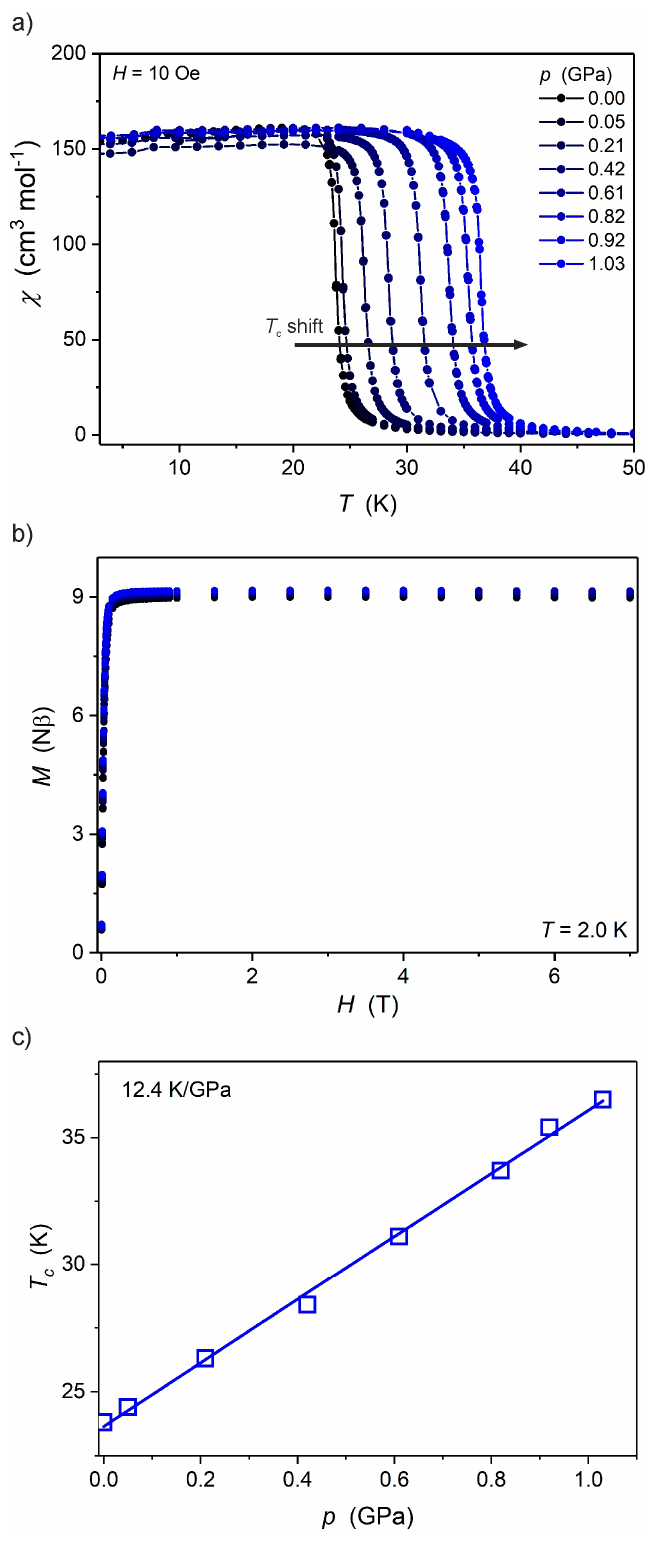
Figure 4. Temperature dependence of molar magnetic susceptibility χ ( T) at 10 Oe ( a ), M ( H ) at 2.0 K ( b ) and T c ( p ) ( c ) for Mn 2 Nb under high pressure. The solid line in (a) is only a guide for the eye, while in (c) it represents the best linear fit.